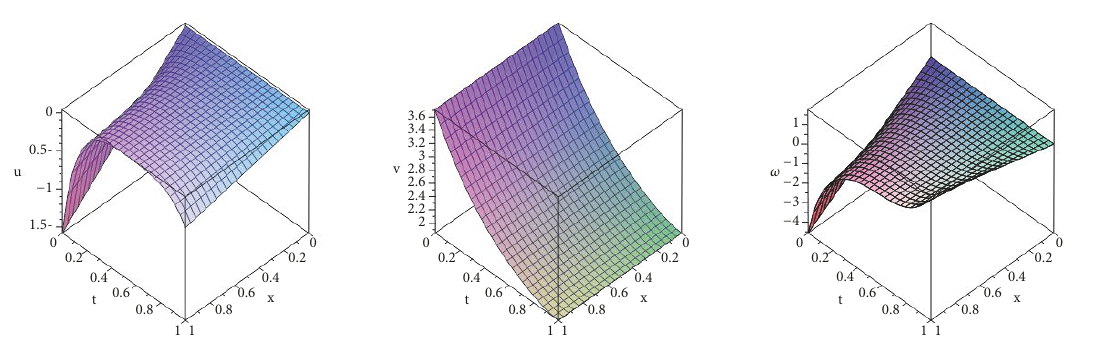
Figure 10: Surface of 𝑢 , V , and 𝜔 for M = 1 , 𝑆 = −15 , 𝛾 = 0.5 , 𝑦 = 1 , 𝛼 = −4 , 𝑙 = 2 .